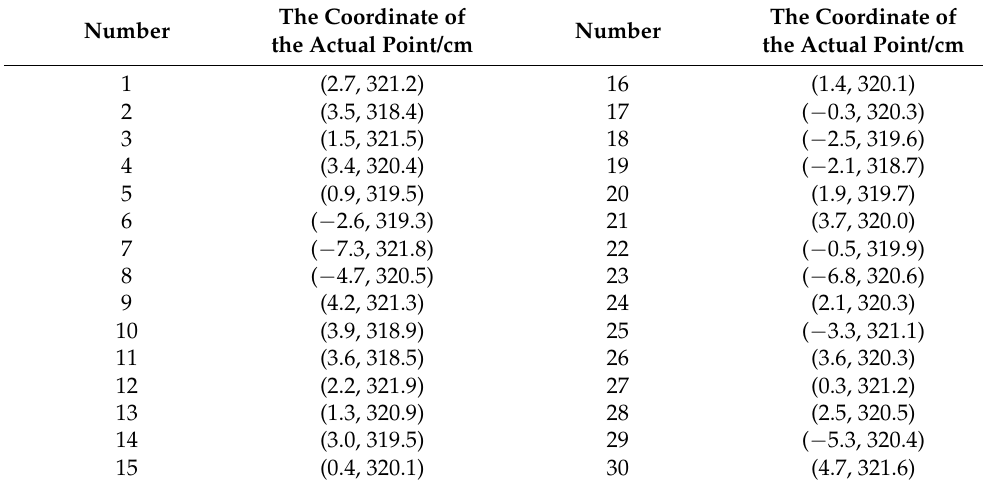
Table 4. Experiment data of straight-line motion in the greenhouse tomato growing